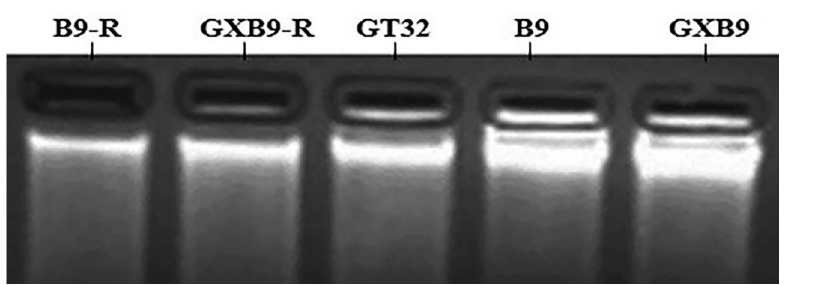
Fig 11. Results of genomic DNA detection with gel electrophoresis.